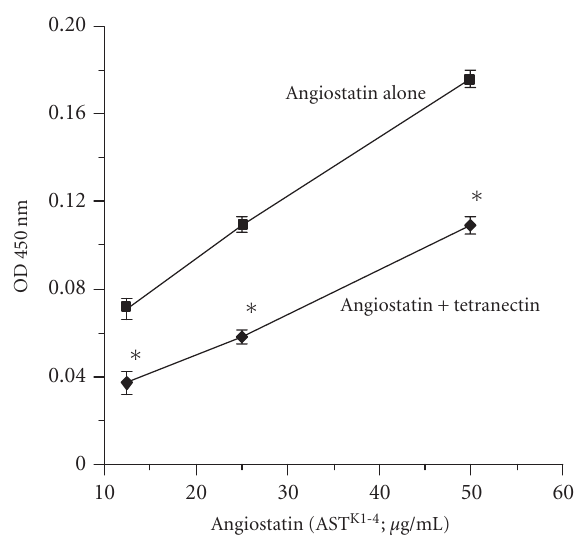
Figure 3. Tetranectin reduces binding of angiostatin to ECM. Binding of angiostatin (AST K1-4 ) to ECM of endothelial cells was measured as in Figure 2. At all concentrations tested, binding of AST K1-4 was significantly reduced by tetranectin ( P < . 05; indi- cated by ∗ ). Results shown are mean ± SEM of 4 experiments (each experiment done in triplicate).